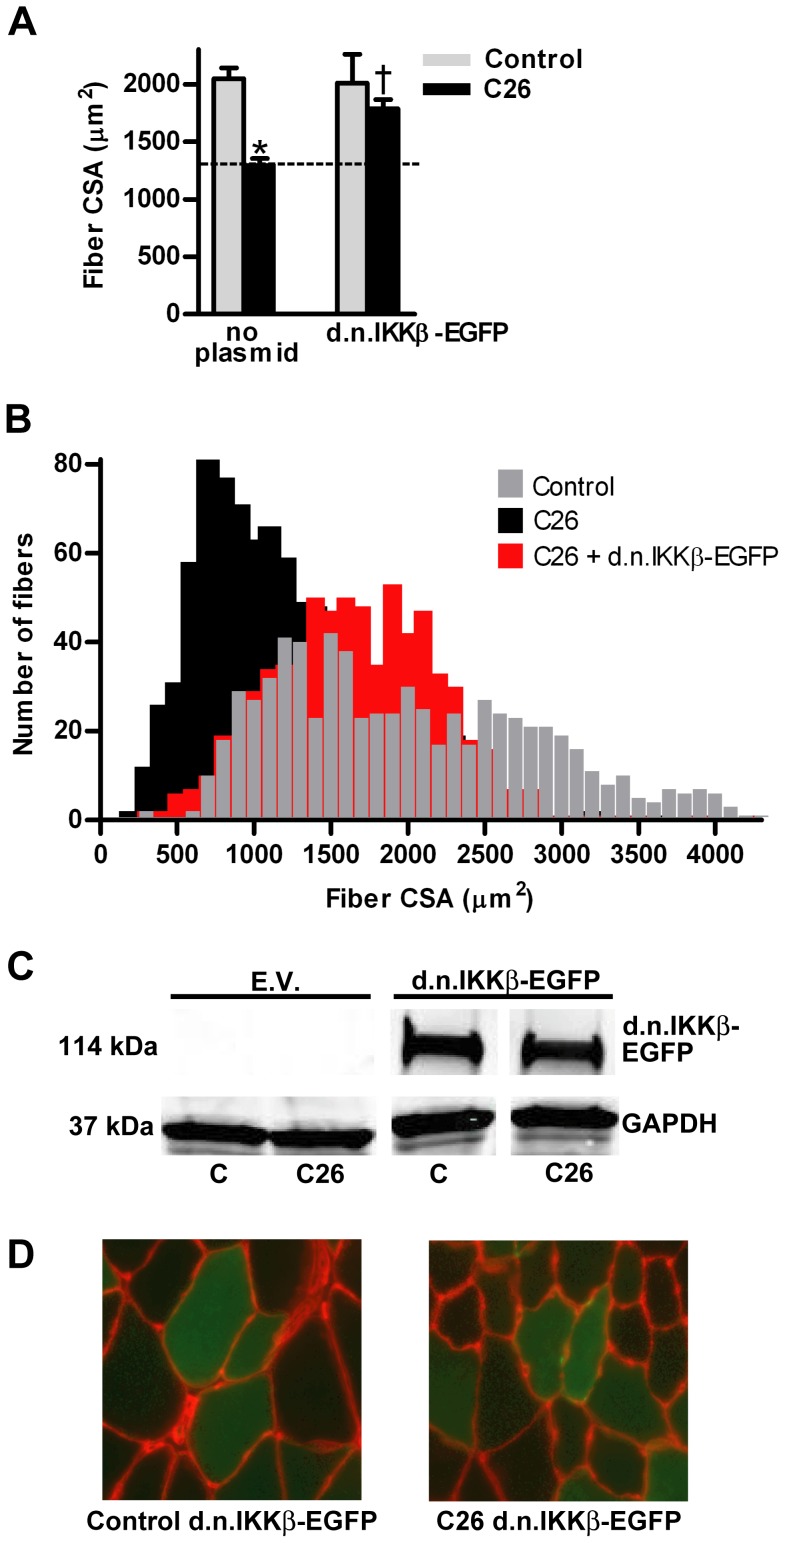
Effects of d.n. IKKβ-EGFP on muscle fiber cross sectional area (CSA).(A) Mean tibialis anterior (TA) fiber cross-sectional area in control and C26 tumor-bearing mice in the presence or absence of d.n. IKKβ-EGFP. Each bar represents mean fiber area from 8 muscles (± SE). The average number of fibers measured per muscle was 200. (B) Fiber area frequency distribution of all fibers from muscles of control, C26, and C26 + d.n. IKKβ-EGFP groups. (C) Western blots of lysates from TA muscles injected with the empty vector (EV) or d.n. IKKβ-EGFP plasmid confirms overexpression of the fusion protein. d.n. IKKβ-EGFP is 114 kDa. All samples are from the same immunoblot. (D) Representative cross sections of TA muscles from control and C26 tumor-bearing mice injected with the d.n. IKKβ-EGFP plasmid. Fluorescent red represents laminin staining (anti-laminin incubation followed by Texas Red-X fluorescent dye-conjugated secondary antibody). Fluorescent green cytoplasm represents expression of transfected d.n. IKKβ-EGFP. C  =  control; * significantly different from control (P<0.05). † significantly different from C26 fibers not transfected with d.n. IKKβ-EGFP (P<0.05).